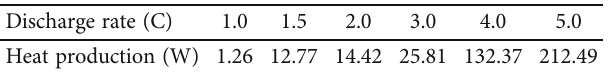
batteries at di ff erent 4